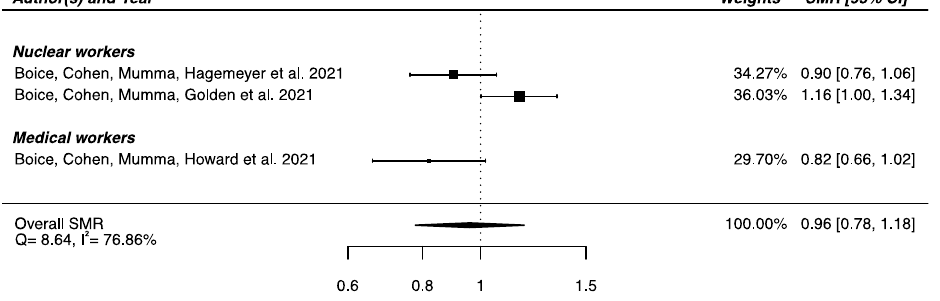
Figure 4. Standardized mortality ratio (SMR) and 95% confidence interval (CI) for mortality from Parkinson’s disease in IR-exposed populations compared with general populations as reference.